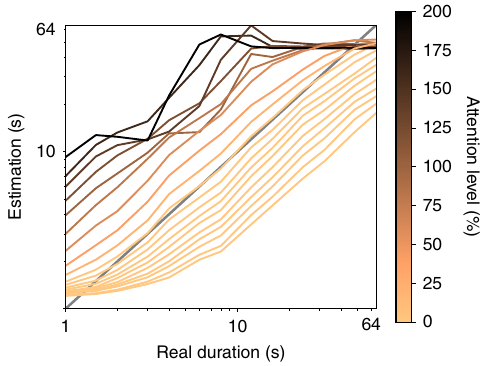
Fig. 4 Comparison of system duration estimation under different attentional modulation. Attentional modulation refers to a scaling factor applied to the parameters T max and T min , speci fi ed in Table 1 and Eq. (1). Changing attention affects duration estimates, biasing estimation across a broad range of durations. The model still generally differentiates longer from shorter durations, as indicated by the positive slopes with increasing real duration, but also exhibits biases consistent with those known from behavioural literature associated with attention to time (e.g. refs. 33,34 underestimation of duration (lighter lines), while higher attention leads to increasing overestimation (darker lines; see Supplemen- tary Fig. 3 for results modulating attention in the other models).